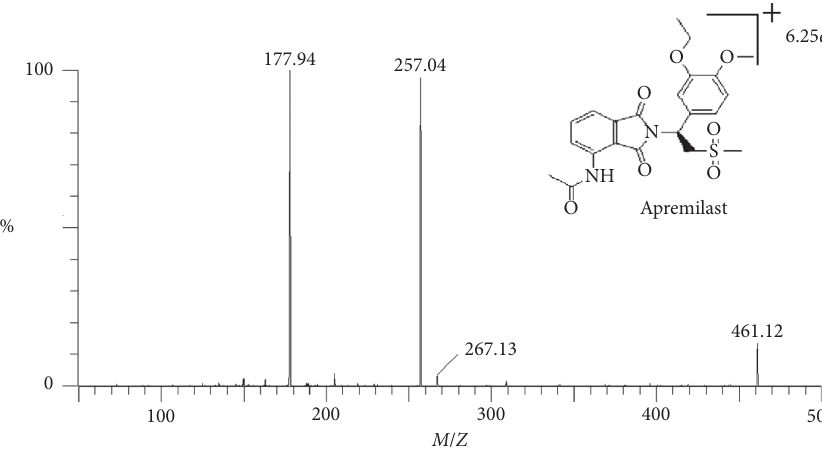
Figure 1: Mass spectra of product ions of apremilast and its